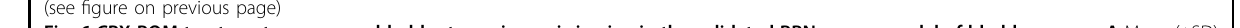
Fig. 6 CPX-POM treatment suppresses bladder tumorigenesis in vivo in the validated BBN mouse model of bladder cancer. A Mean (±SD) plasma ciclopirox (CPX) concentration-time pro fi les following IV administration of 13.4 mg/kg CPX-POM and 18.1 mg/kg CPX-O to three C57BL/6 mice per serial blood collection time point per treatment group demonstrating rapid and complete metabolism of CPX-POM to its active metabolite, CPX. B Mean (±SD) plasma CPX concentration-time pro fi les following administration of 23.4 mg/kg IV and 117.5 mg/kg IP CPX-POM to three C57BL/6 mice per serial blood collection time point per treatment group demonstrating acceptable bioavailability of CPX following IP administration of CPX- POM. C Male C57BL/6 mice received 0.05% of N-butyl-N-(4-hydroxybutyl)-nitrosamine (BBN) in the drinking water for 16 weeks. Mice were treated with vehicle, 235 mg/kg CPX-POM (½MTD), or 470 mg/kg (MTD) CPX-POM IP once daily for 4 weeks (weeks 17 – 20). After 20 weeks, mice were euthanized, bladder was collected weighed, and subjected to further analysis. D CPX-POM treatment signi fi cantly reduced the bladder weight as compared to the vehicle-treated cohort at well-tolerated doses ( p < 0.05). There were no statistically signi fi cant differences in bladder weights between the 235 mg/kg (½ MTD) and 470 mg/kg (MTD) CPX-POM treatment cohorts. E Immunohistochemistry analysis of bladder tumors obtained from CPX-POM-treated mice show a lower number of PCNA-positive nuclei compared to bladder tumors obtained from vehicle-treated mice. Bladder tumors obtained from CPX-POM treated mice also showed reduced expression of Notch 1, Presenilin 1, Hes1, and Nicastrin and increased levels of cleaved caspase-3 compared bladder tumors obtained from vehicle-treated